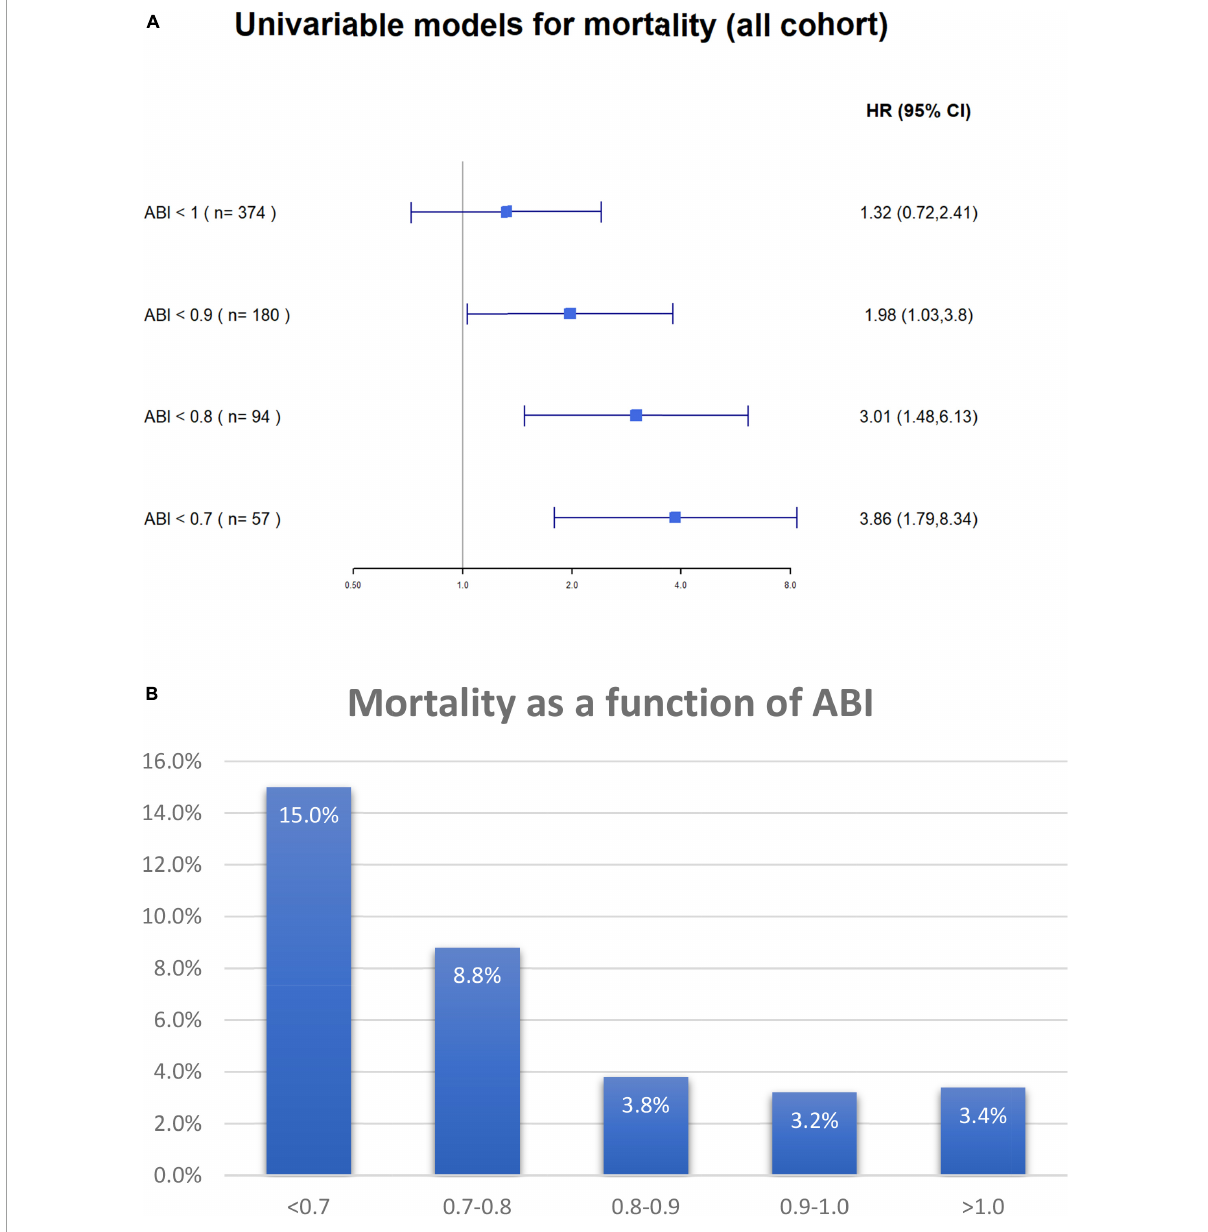
FIGURE5 (A) Univariable Cox proportional hazard models for 17-months (maximal follow-up time) all-cause mortality according to ABI value. The figure demonstrates the difference in mortality according to ankle-brachial index cutoff points. N in each model (shown in parenthesis) regards to the number of patients with ABI less than 1, 0.9, 0.8, and 0.7 accordingly. ABI, ankle-brachial index. (B) Overall mortality according to ABI groups. ABI, ankle-brachial